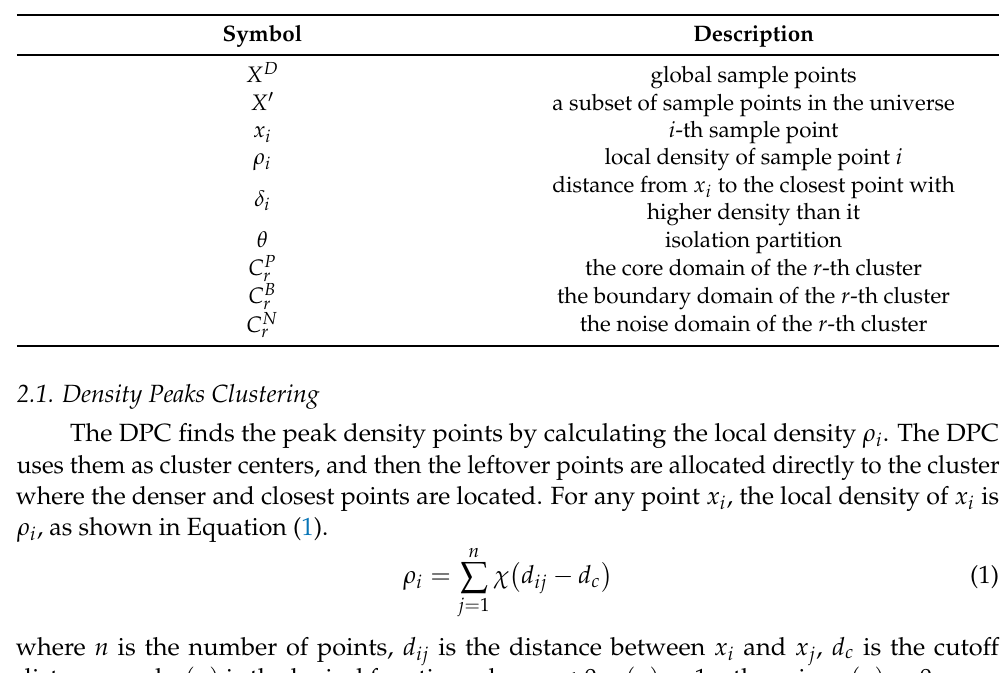
Table 1. Symbols and